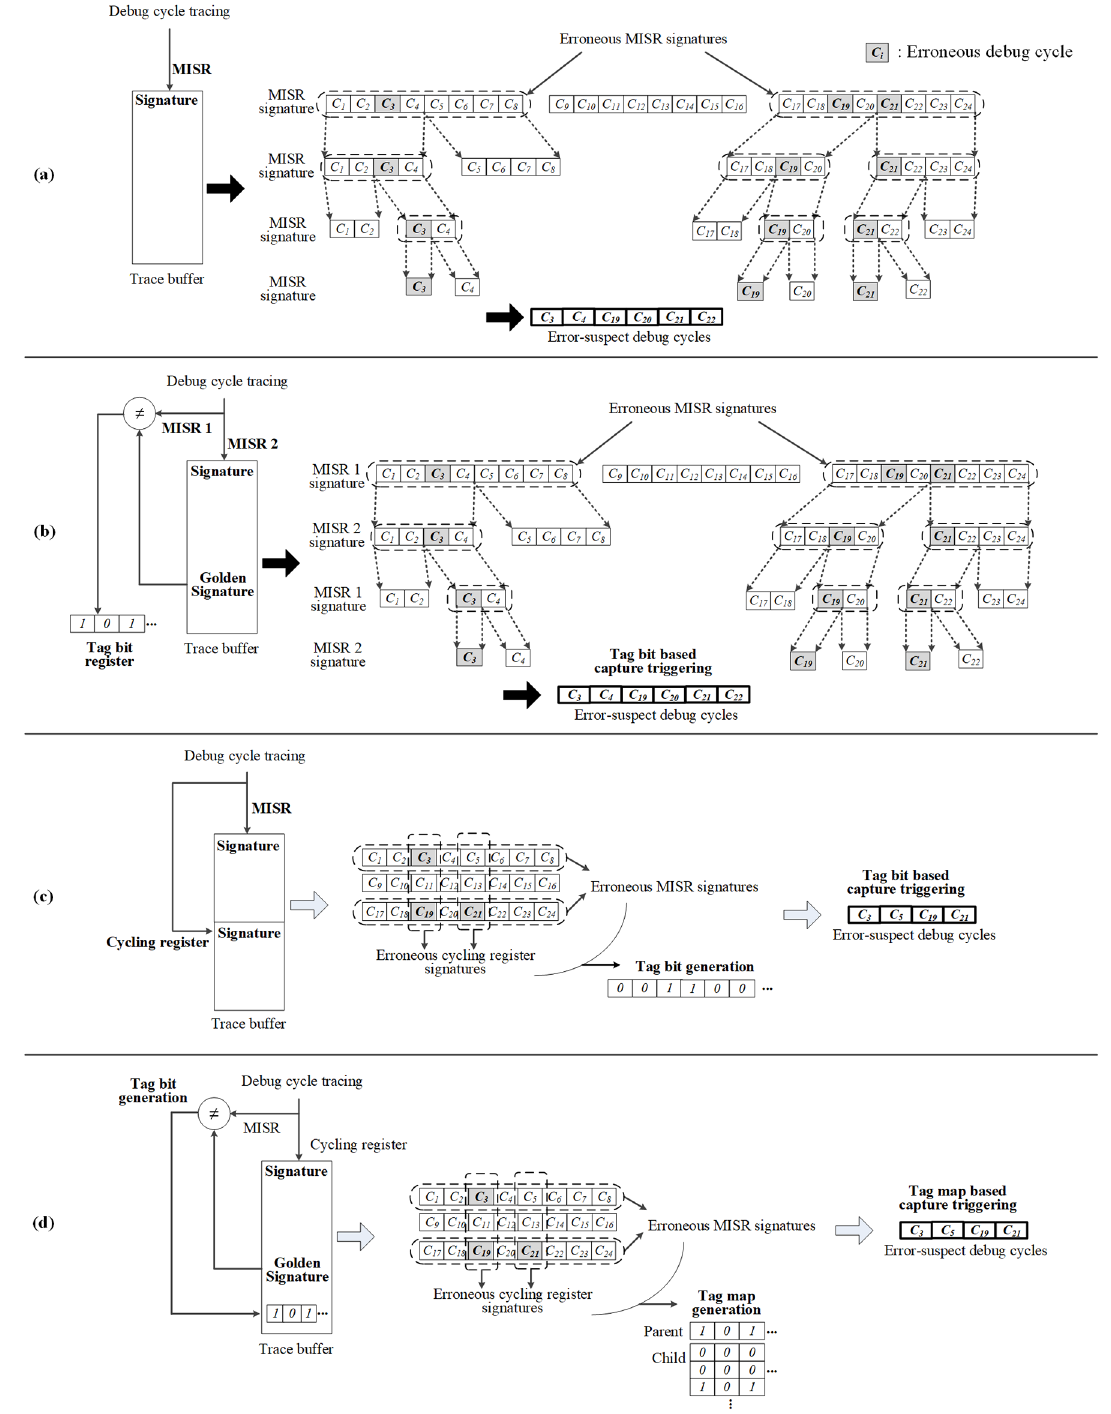
Fig 1. The previous debug techniques: (a) debug technique in [9]; (b) debug technique in [11]; (c) debug technique in [12]; (d) debug technique in [13].